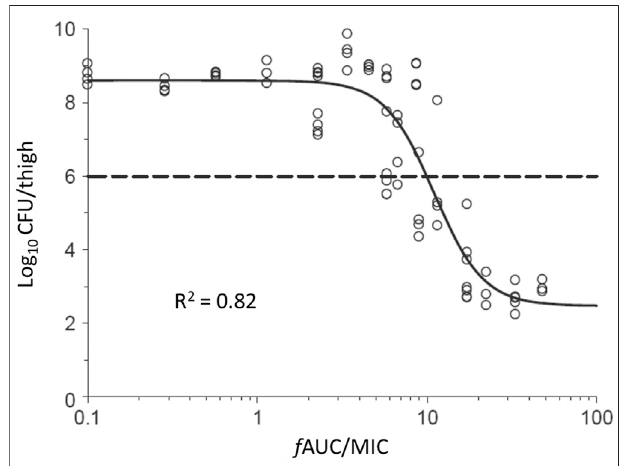
FIGURE 2 | Relationship for Pseudomonas aeruginosa ATCC 27853 between the log 10 colony forming units (CFU) per thigh at 24 h and f AUC/MIC ofcolistin(Cheah et al.,2015).Each symbol representsthe valuefrom asingle thigh. The data points on the y -axis are for untreated (control) mice at 24 h after commencement of therapy in the animals treated with colistin. The dotted line represents the average bacterial burden in the thighs at the start of colistin treatment. The fi gure is panel “ a ” of Figure 3 in the original publication of Cheah et al.,